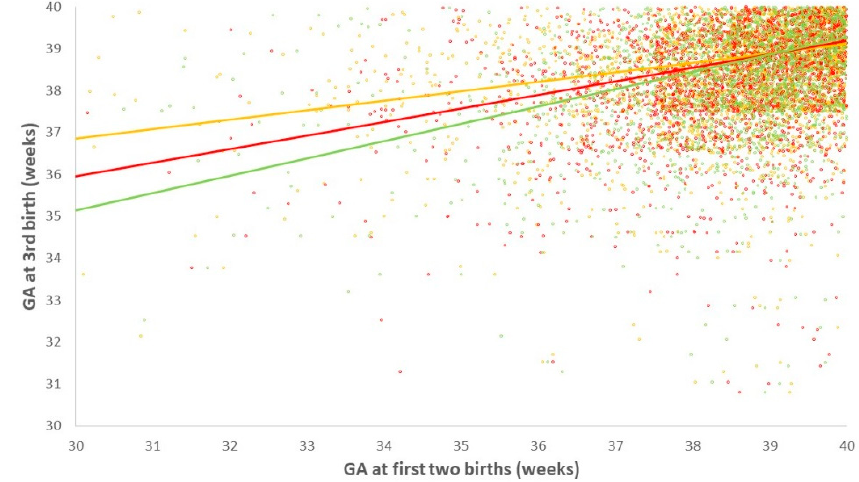
Figure 3. Relationship between gestational age at the third delivery and gestational age at the first two deliveries.